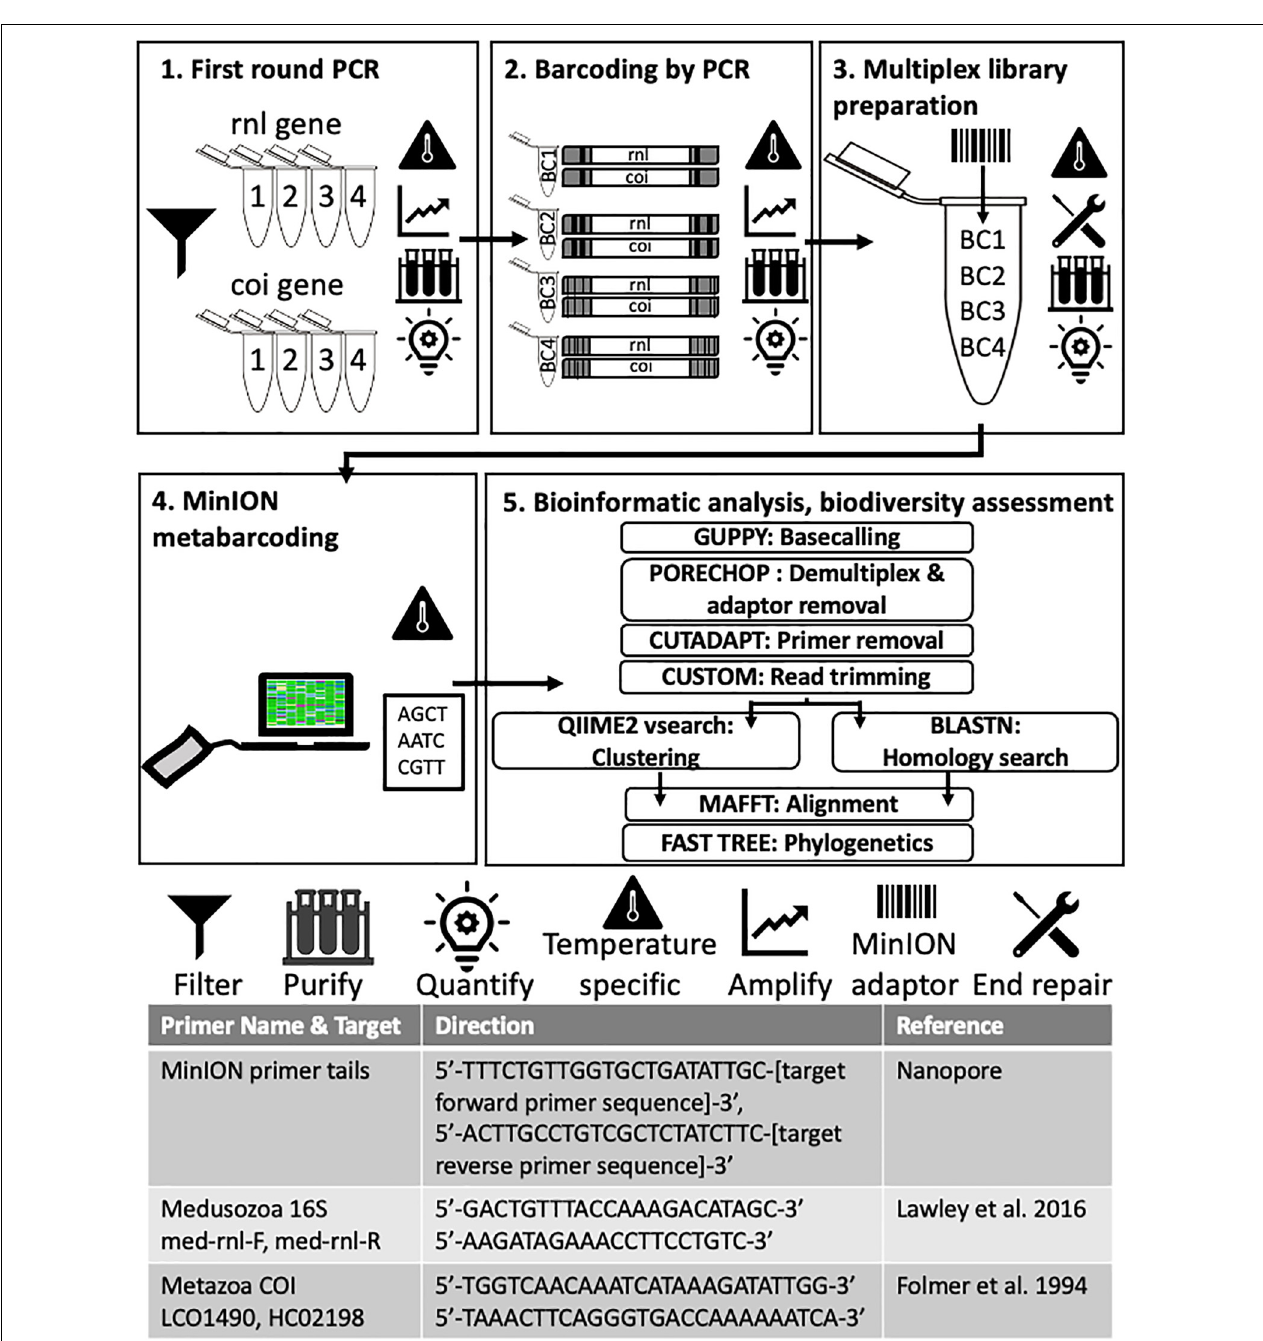
FIGURE 3 | Molecular and bioinformatic components of the FeDS workflow. (1) First round PCR. Two genetic targets were amplified from eDNA samples (16S rRNA gene and COI, 4 miniPCR wells each). Primers and MinION primer tails provided in the table at the bottom. Amplicons pooled by collection site. (2) Barcoding by PCR. In the second round PCR, unique nanopore barcodes were added to each pooled amplicon sample. (3) Multiplexed library preparation. Input DNA was end-repaired and dA-tailed, and adapters were added. ( 4) MinION metabarcoding. The prepared sequencing library was loaded onto an R9.4 flow cell (FLO-MIN106, ONT) and sequenced using the MinION Mk-1B and MinKNOW v 1.2.8. (offline version), on a laptop. Icons = Filter: Seawater filtered through 0.45 µ m Gridded Sterile Cellulose Nitrate Membrane, and eDNA isolated using extraction kit. Purification: Impurities removed with AMPure XP beads; purified DNA eluted in 31 µ l nuclease-free water followed by quantification with the QuantiFluor portable fluorometer using QuantiFluor ONE dsDNA HS assay, after every step. Temperature specific: PCR step (amplification), or cold incubation 20 ◦ C, or controlling MinION temperature (to = < 35 ◦ C) with battery-powered mini-fan. MinION adaptor: unique nanopore barcodes (EXP-PBC001, ONT) added to each amplicon sample. End repair: End-repaired and dA-tailed using NEBNext End Repair/dA-tailing (NEB). (5) Bioinformatic analyses and biodiversity assessments. Software programs in upper case letters, followed by respective application. Refer to code: https://github.com/aohdera/Ames_et_al_2020.